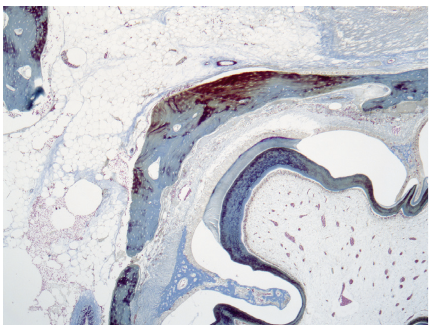
Figure 12: Histological picture of the cross section of the mandible of the rabbit 4 weeks after the formation of a bone defect and introduction of calcium hydroxide suspension.